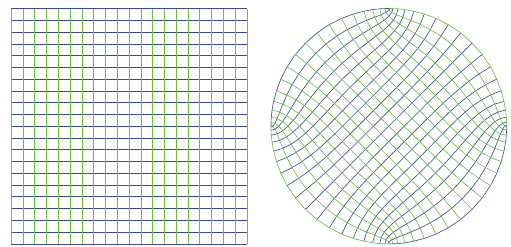
Figure 2: Conformal mapping of a square onto a circle, used for automatic parametric mesh